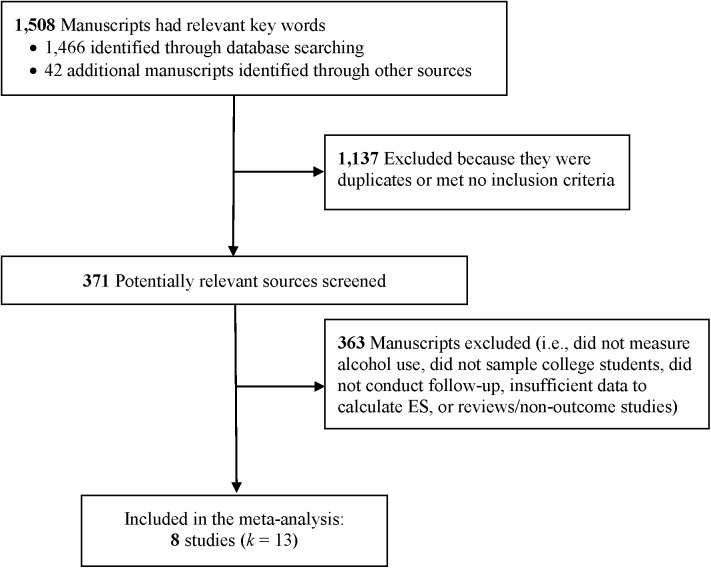
Study flow diagram.